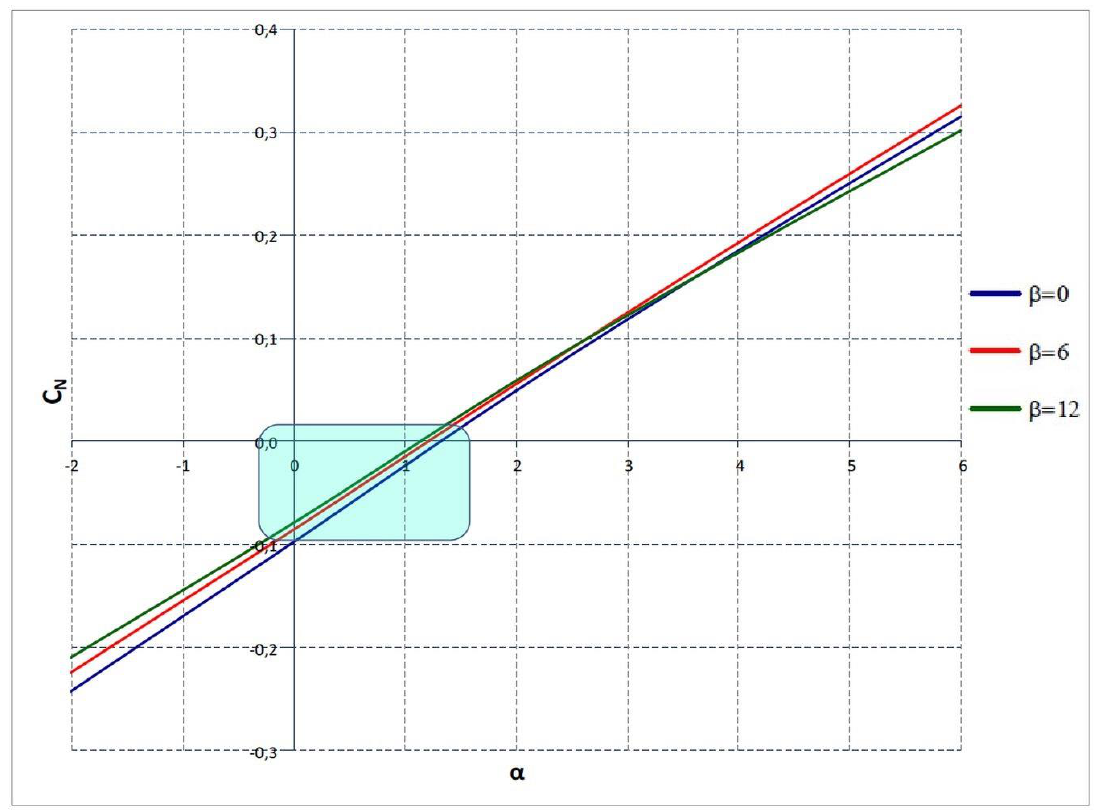
Figure 7. Close up look at a minimum angle of attack range for C N = f (α) for different sliding angles β with Re = 16,000 for FF model.